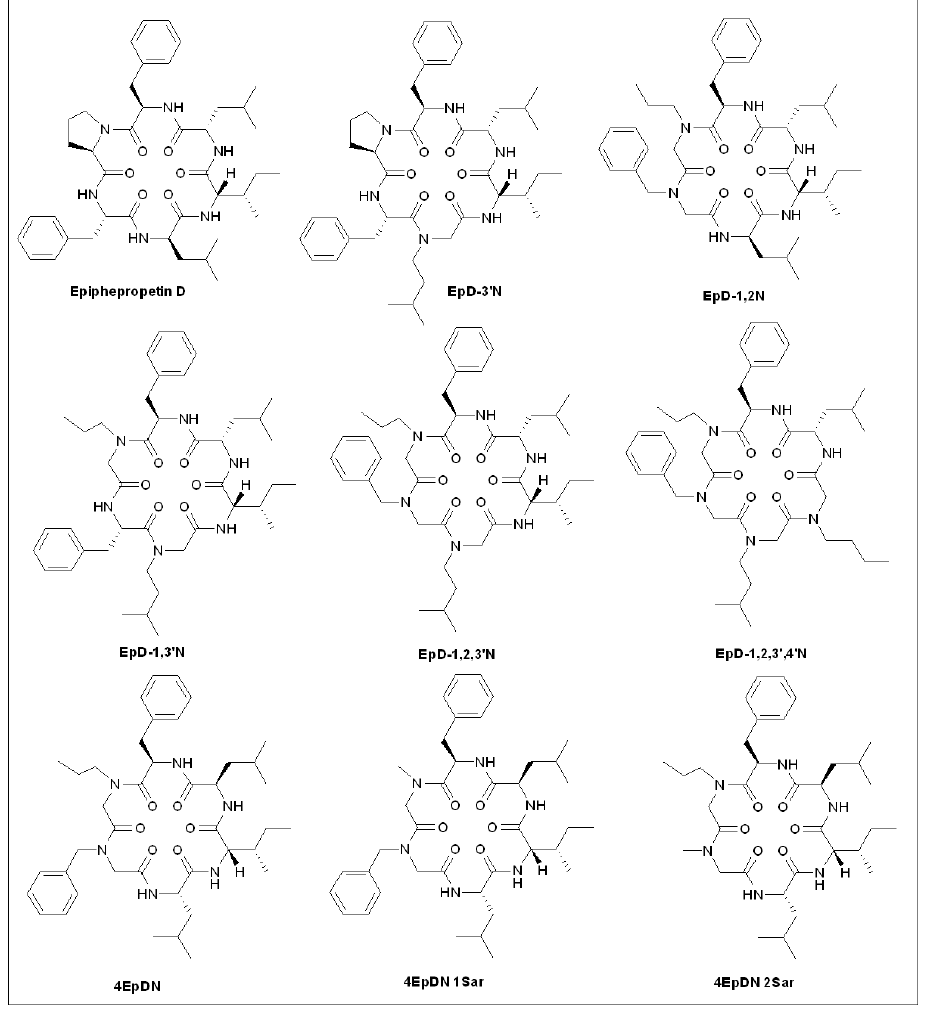
Figure 7. Structures of epiphepropeptin D derivatives.